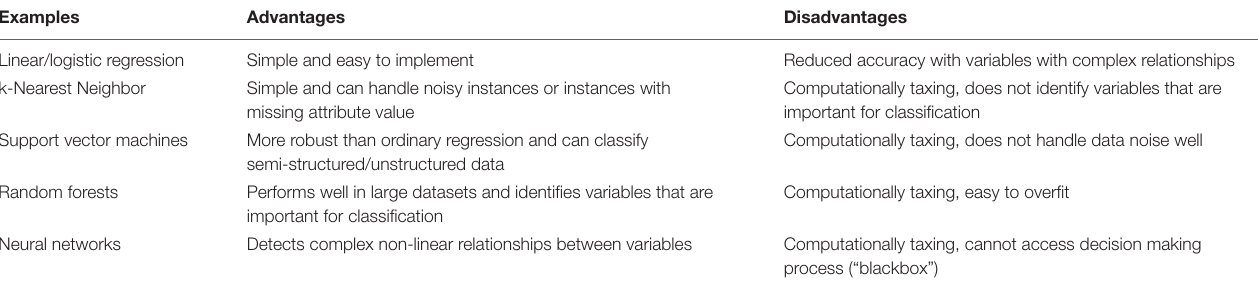
TABLE 2 | Original and validation studies of clinical AF risk